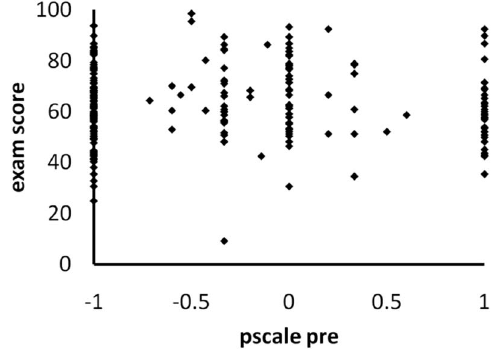
FIG. 3. The correlation between pscale at beginning of the se- mester and the exam score, where pscale= (cid:1) expansive −limiting (cid:2) / (cid:1) expansive+limiting